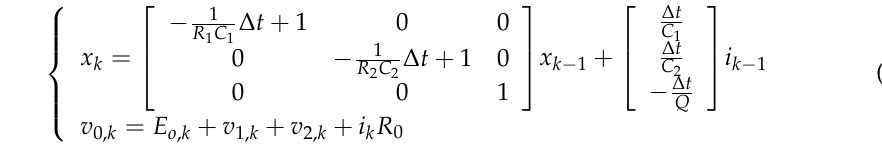
3.2. EKF-Based E-Cell SOC Estimation The Kalman filter (KF) algorithm is widely used in control applications and has a significant accuracy advantage in system estimation when the system noise satisfies the Gaussian distribution [23,24]. However, the classical Kalman filter is less suitable for non- linear systems and more suitable for linear systems, while EV have non-linear character- istics. The operation principle of the EKF model is shown in Figure 2. The EKF model is